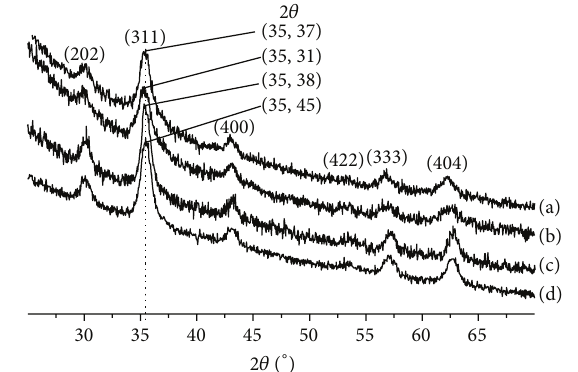
Figure 2: X-ray diffraction patterns for the ferrite powders prepared from diethylene glycol solution at ∼ 200 ∘ b : (a) MnFe 2 O 4 ; (b) CoFe 2 O 4 ; (c) NiFe 2 O 4 ; (d) ZnFe 2 O 4 .